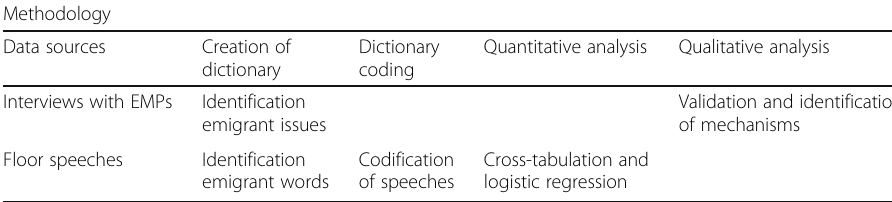
Table 4 Methodological steps and data sources. Source: Author ’ s